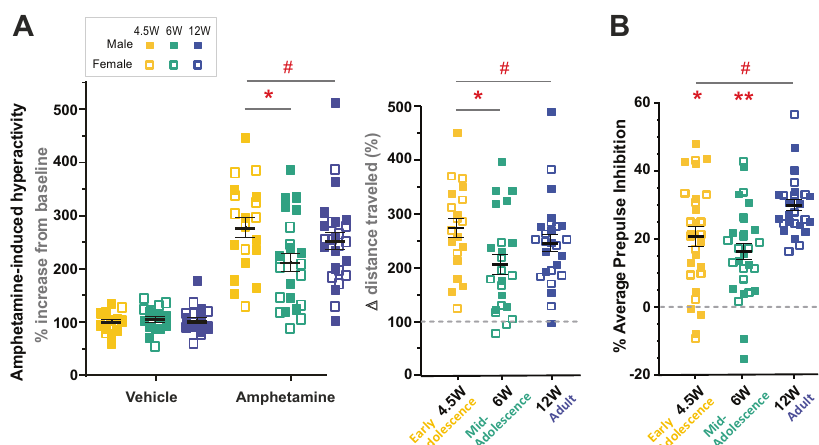
Fig. 2 Drug-induced locomotor hyperactivity and prepulse inhibition during adolescence and adulthood. A Amphetamine-induced hyperactivity (% increase from pretreatment baseline (left) and % change from vehicle saline-treated animals (right)). % increase from baseline (left): Signi fi cant effect of treatment ( F (1,129) = 172.19, P < 0.001) and an age x treatment interaction ( F (2, 129) = 3.49, P = 0.034) with amphetamine inducing locomotor hyperactivity (ANOVA test with age, sex and treatment as independent factors). Examining individual treatments using a two-way ANOVA, saline vehicle-treated animals showed no effect of age ( F (2, 60) = 0.14, P = 0.874), sex ( F (1, 60) = 0.95, P = 0.334), or age × sex interaction ( F (2, 60) = 0.96, P = 0.391). Amphetamine-treated animals showed a signi fi cant effect of age ( F (2, 68) = 3.78, P = 0.028), but no sex ( F ( 1, 68 ) = 1.04, P = 0.313) or sex × age interaction ( F (2, 68) = 2.16, P = 0.123). Dunnett ’ s multiple comparisons post hoc tests using adult mice as the reference group showed 12 W mice were not signi fi cantly different to 4.5 W ( P = 0.514) or 6 W mice ( P = 0.177). However, since we observed an effect of age, Bonferroni ’ s multiple comparisons test revealed mid-adolescent animals showed a signi fi cantly lower drug-induced locomotor response compared to early adolescent mice ( P = 0.041). % change from vehicle saline-treated animals (right): Signi fi cant effect of age ( F (2,68) = 4.18, P = 0.020) but not sex ( F (2,68) = 2.42, P = 0.125) or age × sex interaction effects ( F (2,68) = 2.98, P = 0.058), two-way ANOVA. Dunnett ’ s multiple comparisons post hoc tests using adult mice as the reference group showed 12 W mice were not signi fi cantly different to 4.5 W ( P = 0.391) or 6 W mice ( P = 0.173). Since we observed an effect of age, Bonferroni ’ s multiple comparisons test showed mid-adolescent animals were signi fi cantly different early adolescent mice ( P = 0.024). Data for individual mice are displayed together with mean ± SEM. #Main effect of age P < 0.05; * P < 0.05 between 4.5 and 6 W. Each point represents an individual mouse. B Percentage prepulse inhibition (average for prepulse 6, 12 and 18 combined only for the purpose of data visualization). Signi fi cant effect of age ( F (2,85) = 7.76, P < 0.001) but no effect of sex ( F (2,85) = 0.11, P = 0.746) nor age × sex interaction effects ( F (2,85) = 0.13, P = 0.879). Both 4.5 W ( P = 0.018) and 6 W ( P < 0.001) mice were signi fi cantly different to 12 W mice; repeated measures (3 prepulses) ANOVA with post hoc Dunnett ’ s multiple comparisons test using adult mice as the reference group. See Fig. S3B for additional analysis on effect of age on prepulse inhibition. Data for individual mice are displayed together with mean ± SEM. #Main effect of age P < 0.05, * P < 0.05, ** P < 0.01 relative to 12 W sex-matched mice. Each point represents an individual